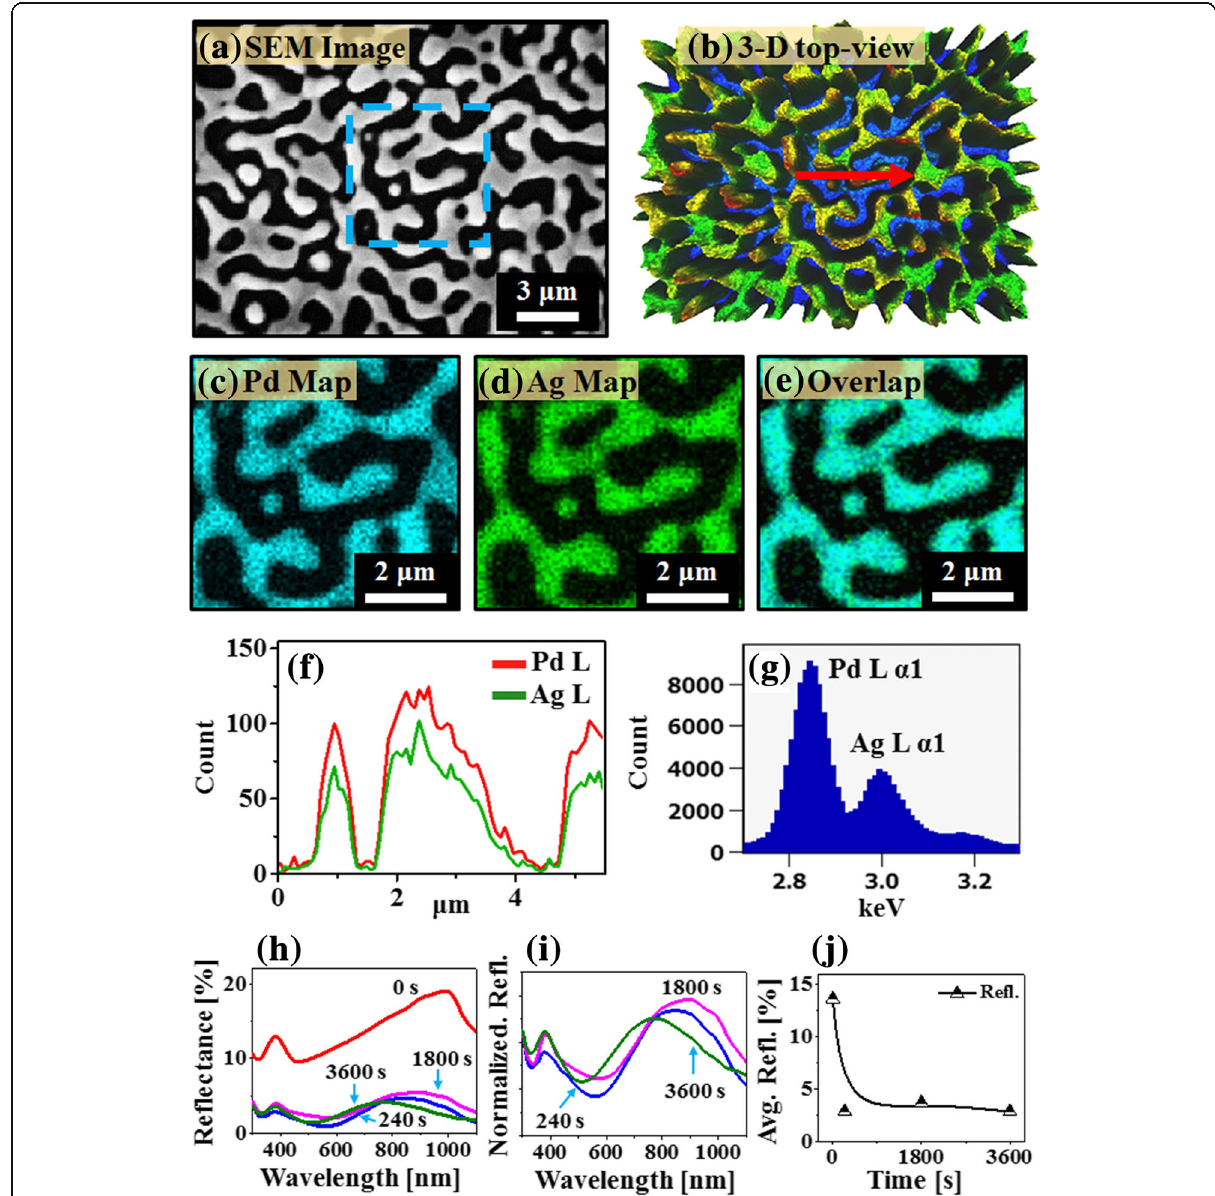
Fig. 7 Elemental and optical analysis of PdAg bi-metallic nanostructures (bi-layers). a SEM image of the 0 s sample. b Top view of corresponding 3D map. c – e Maps of Pd, Ag and Pd and Ag together, boxed region in a . f EDS spectral line profiles of Pd and Ag, arrow location in b . g